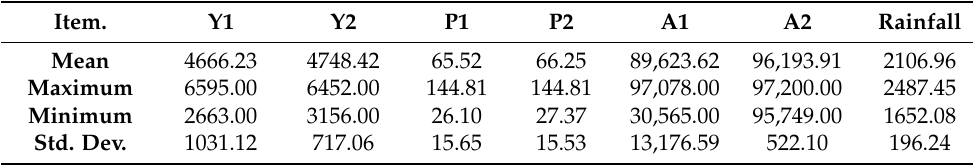
Table 1. Descriptive statistics of selected variables.